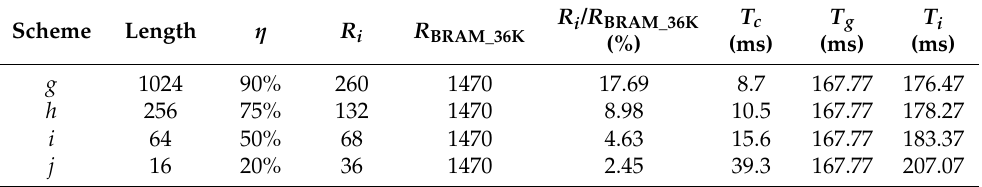
Table 5. Theoretical resource usage and calculation time of different matrix transposition schemes.